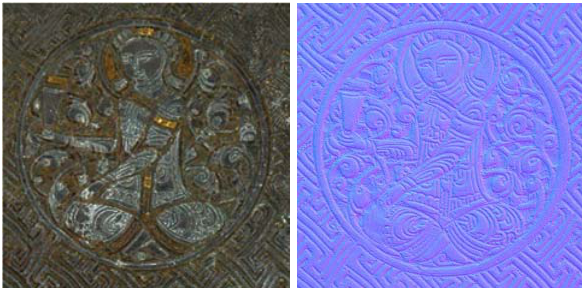
Figure 11. A detail of a roundel design on the Islamic handbag showing: (left) albedo; (right) surface normals.